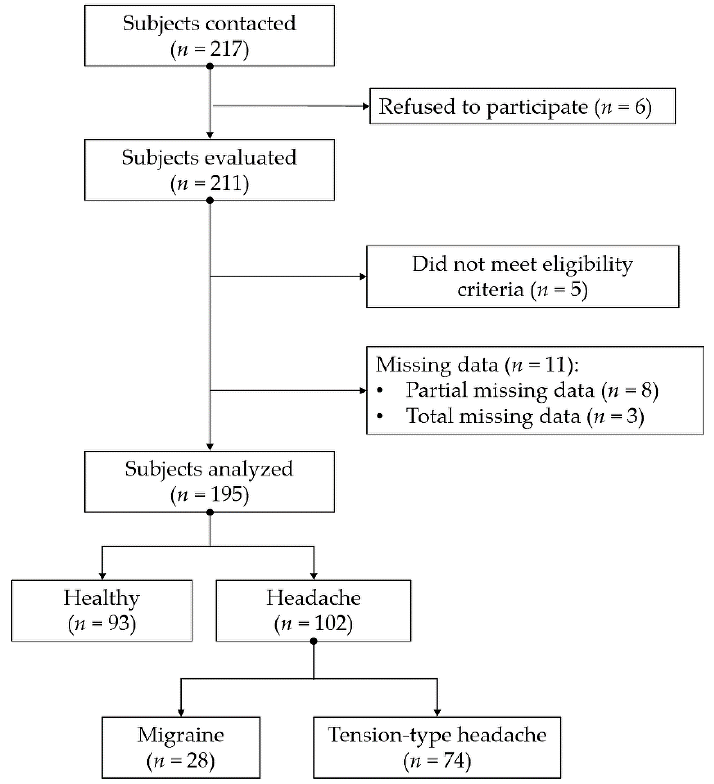
Figure 1. Flow chart of the participant selection process.